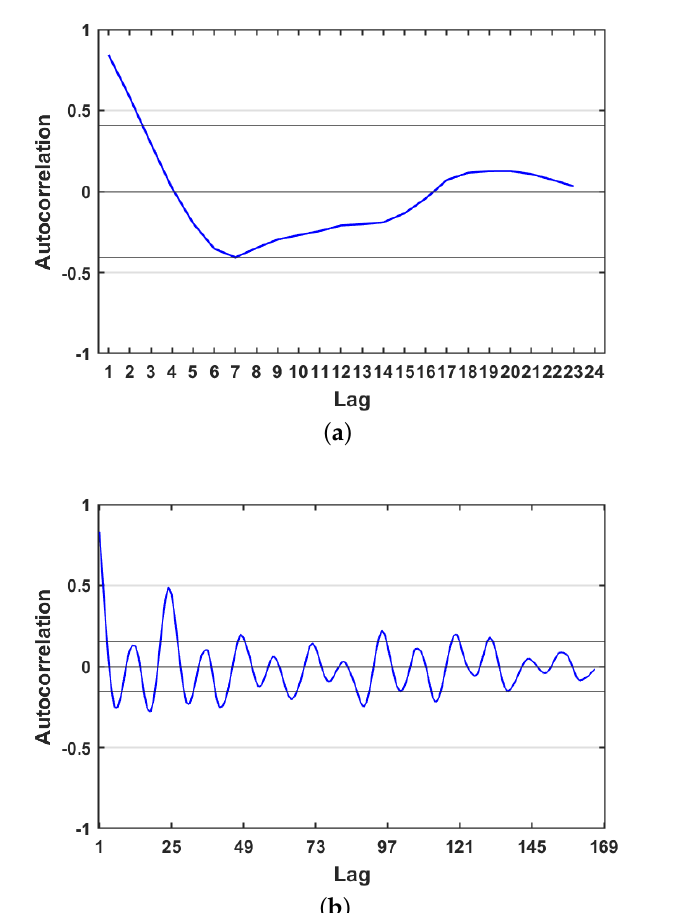
Figure 3. Autocorrelation of PN concentration. ( a ) Autocorrelation coefficient of PN with respect to 24 h. ( b ) Autocorrelation coefficient of PN with respect to 168